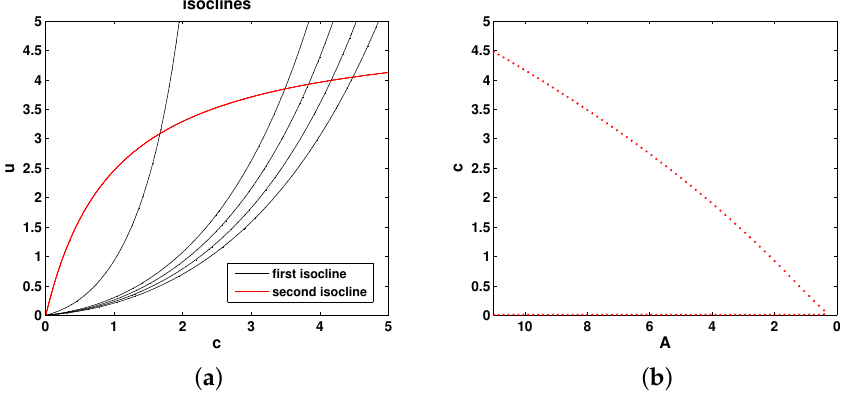
Figure 7. ( a ) The (null-)isoclines of the oxygen-phytoplankton system for Model 6. Black curves show the oxygen isocline ( u I ) for A = 3.5,8,9,10 and 11 (from left to right, respectively), and the red curve shows the phytoplankton isocline ( u II ). ( b ) Positive steady states of Equations (20) and (21) shown as functions of A . Parameters are the same as in Figure